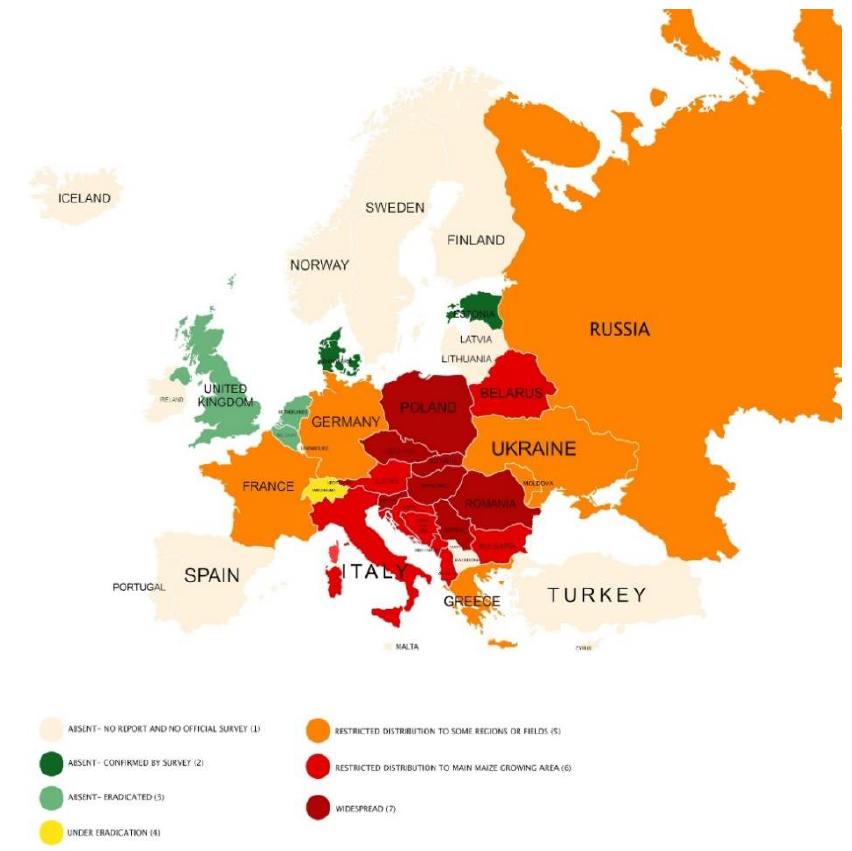
Figure 2. The distribution map of western corn rootworm in Europe—countries are categorized according to pest presence and population level in seven categories (1–7) based on EPPO Global Database [48] and other literature data [53,58,62,69,239], in addition to data reported by Bieńkowski and Orlova-Bienkowskaja, [62] Modič et al. [53], Raileanu and Odobesky, [239] Voineac et al. [63], and Voineac et al. [69].